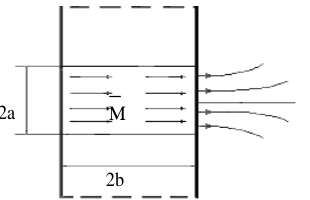
Fig 12. Scheme of a magnetic flux in volume V M from six sec- tions along an